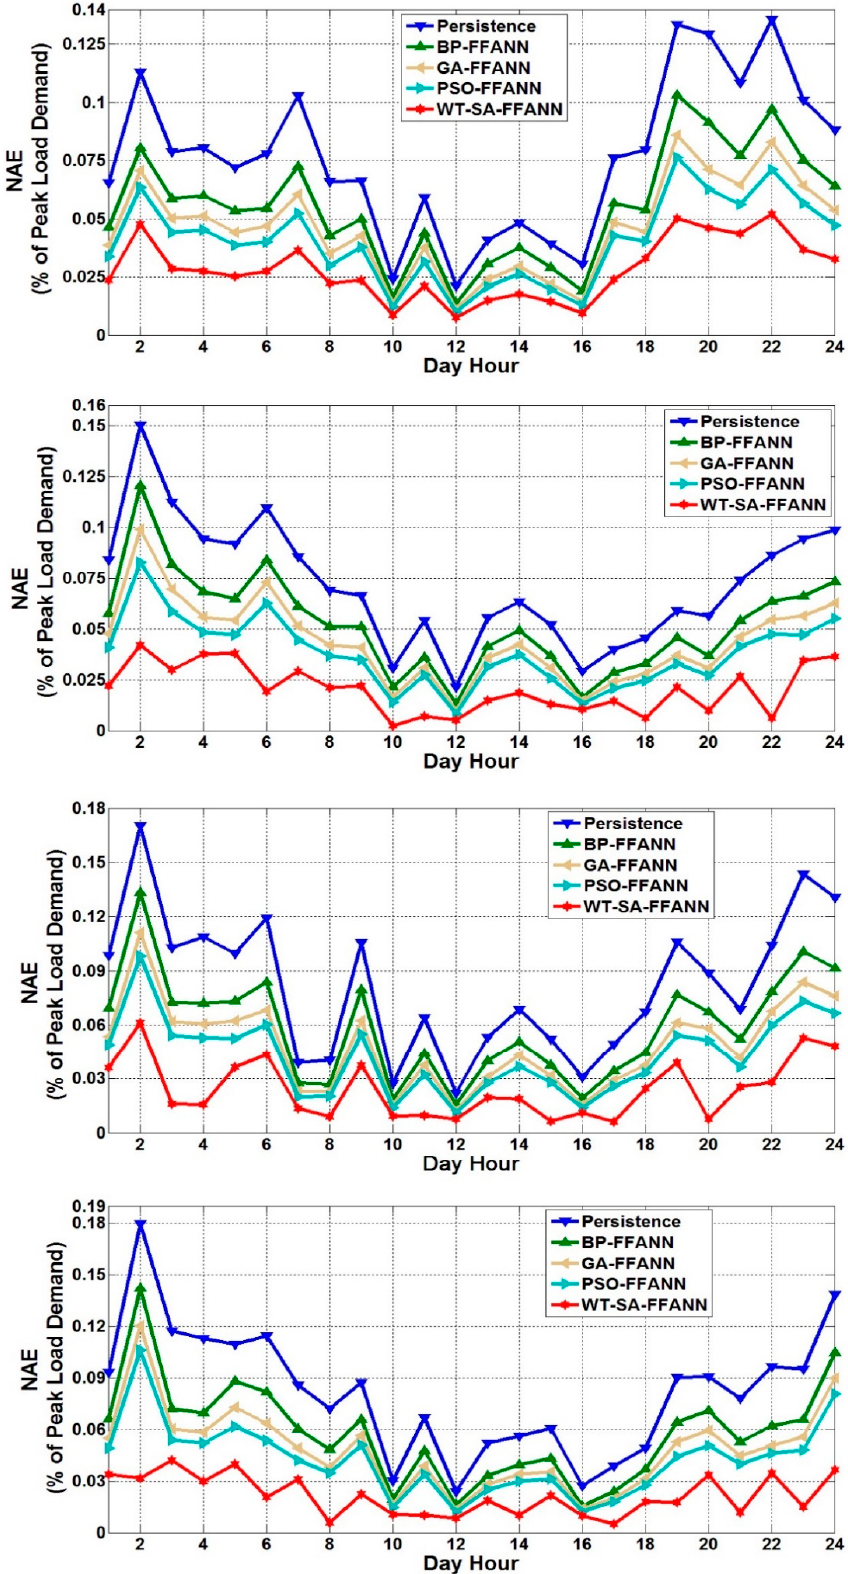
Figure 14. NAE for weekends / holidays (the first curve for the winter holiday, second curve for the spring weekend, third curve for the spring weekend and fourth curve for the fall weekend).